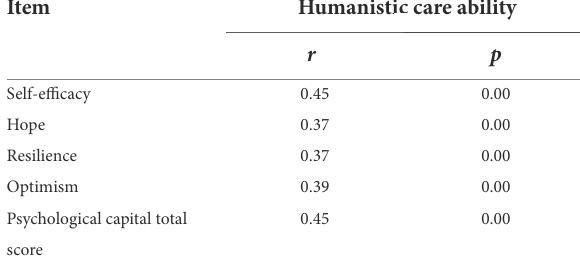
TABLE 7 Correlation analysis of psychological capital and humanistic care ability of